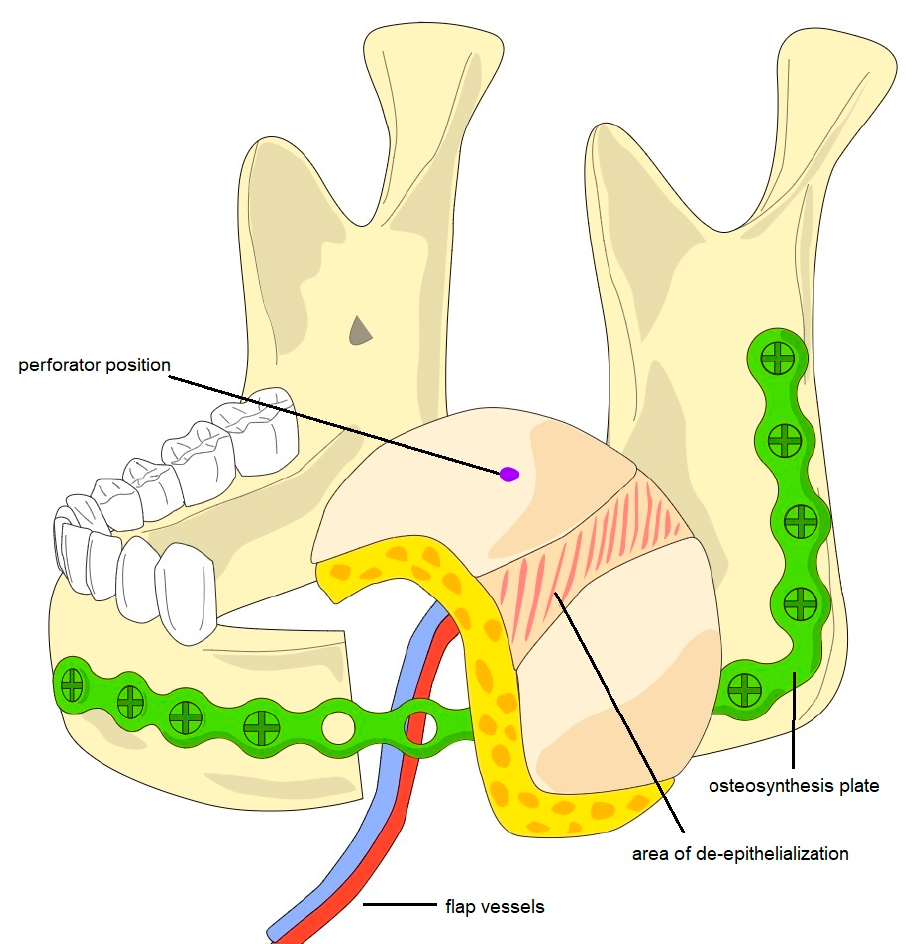
Figure 1. Schematic diagram of a partially de-epithelialized ALT flap and an osteosynthesis plate for the reconstruction of a full-thickness defect after tumor resection with segmental resection of the left-sided mandible. After segmental resection and the individualization of an osteosynthesis plate, the ALT flap was harvested. The prepared flap then underwent partial de-epithelialization in order to create two skin paddles for restoration of the oral and the facial